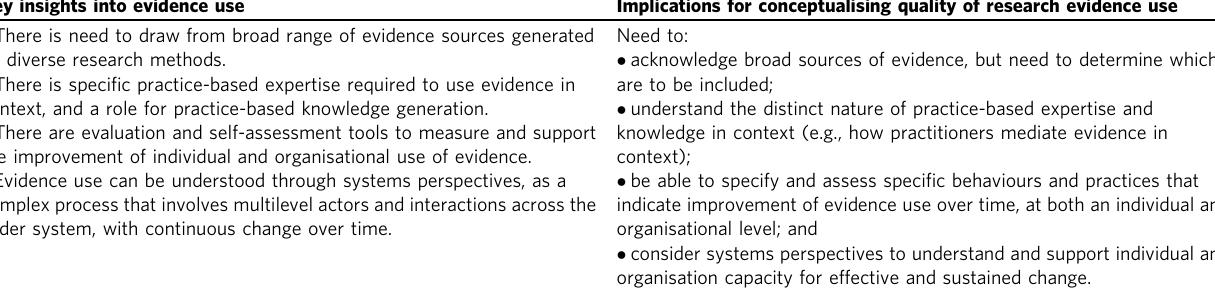
Table 2 Cross-sector insights and their implications for conceptualising quality of research evidence